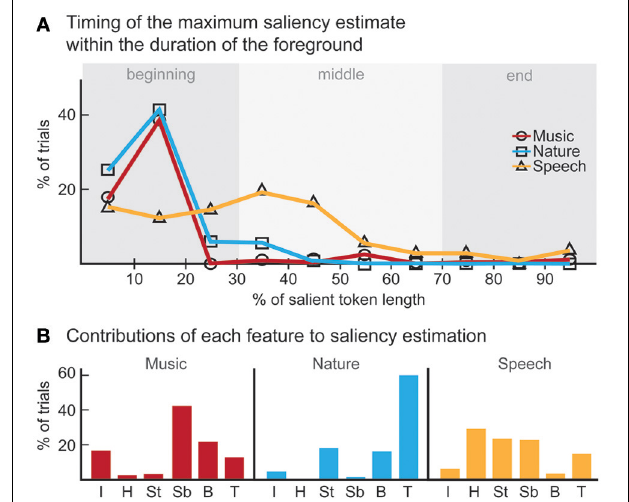
FIGURE 5 | Analysis of model results. (A) The time instance where the maximum likelihood of saliency was detected for foreground tokens in the scene. Trials in which the maximum saliency was found outside the duration of the foreground are not included. For musical notes and bird songs, the deviance is detected soon after the token onset. For spoken words, the deviance is detected during the first half of the token onset. In some cases, the model finds the offset deviance instead of onset deviance. (B) Regardless of whether the maximum likelihood of saliency was inside the foreground token duration, the feature that the saliency was detected in is shown. The features are, in order: Envelope, Harmonicity, Spectrogram-top, Spectrogram-bottom, Bandwidth, Temporal